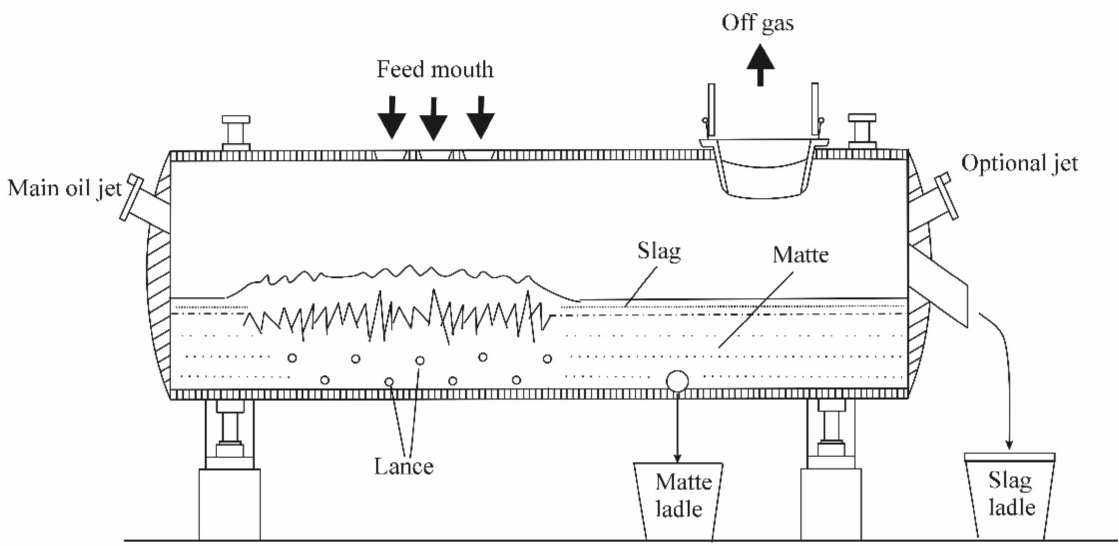
Figure 2. The bottom-blowing furnace at Dongying Fangyuan Nonferrous Metals. Reprinted with permission from ref. [7]. Copyright 2021 John Wiley and